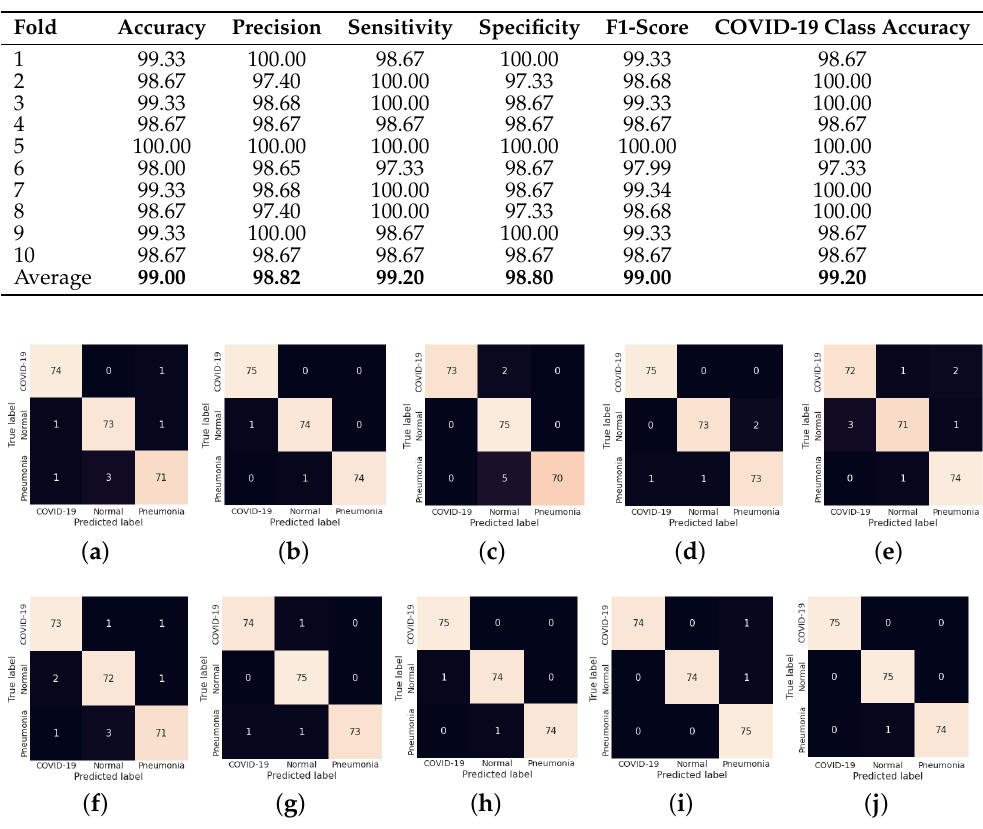
Figure 5. ( a – j ) Confusion matrix obtained by LW-CORONet fold-wise (fold 1 to fold 10) for multi-class classification case.